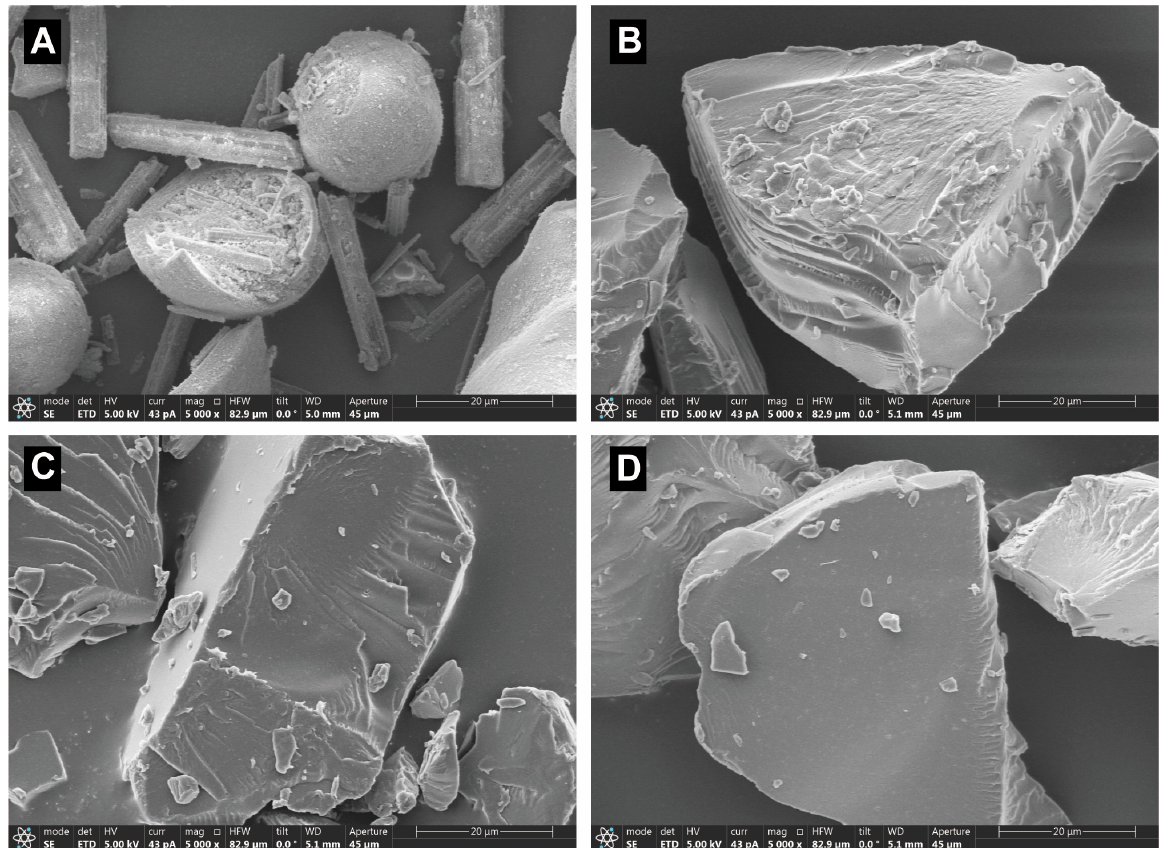
Figure 8. The structure and morphology of physical mixtures of ritonavir/PVPVA/Span 20 ( A ) and milled extrudate of Formulation A ( B ), Formulation B ( C ), and Formulation C ( D ).